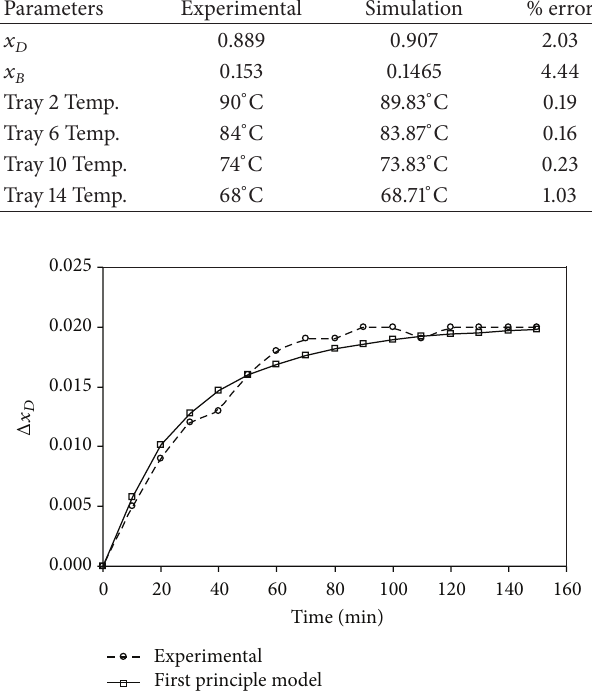
Figure 3: Comparison between experimental and simulated responses in top product composition for positive step change in reflux flow